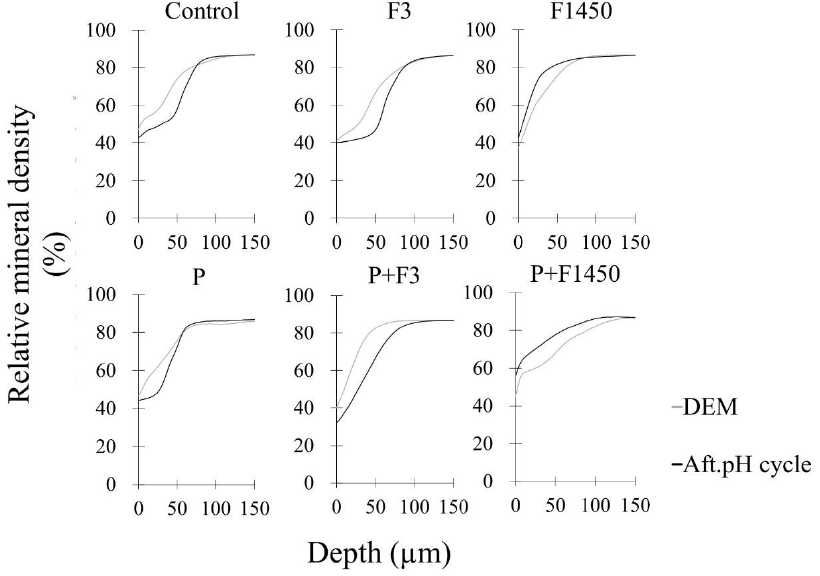
Figure 3. Relative mineral density of DEM and aft. pH cycle for the six groups. The mineral density was normalized to 87% ( v / v ) in sound enamel by Image J quantifying. Table 2. Mineral recovery of enamel subsurface lesions assessed by TMR (mean ± SD). Values marked by the same superscript letters denote no significant differences. ML DEM : Mineral loss